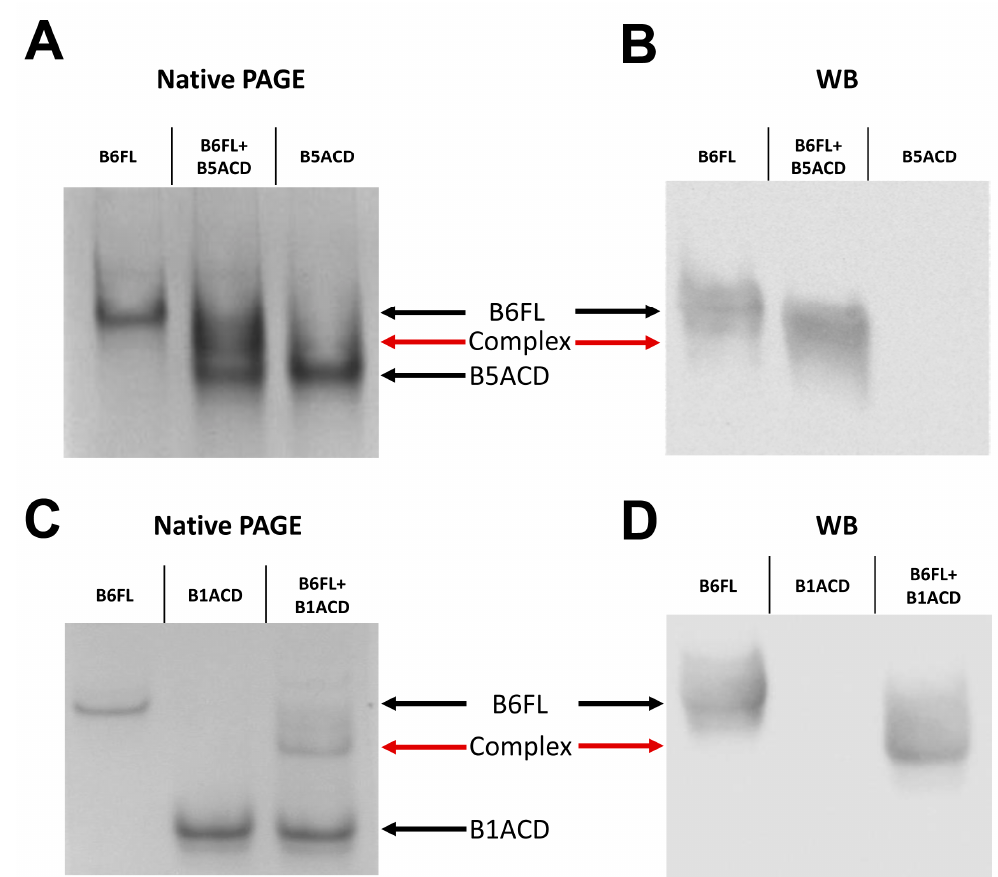
Figure 7. Interaction of full-length HspB6 (B6FL) with ( A , B ) B5ACD and ( C , D ) B1ACD, analyzed by ( A , C ) native PAGE, followed by ( B , D ) Western blotting stained with monoclonal anti-HspB6 antibodies. The positions of the HspB6, ACDs and their complexes are marked with arrows. Representative results of no less than five experiments are presented.